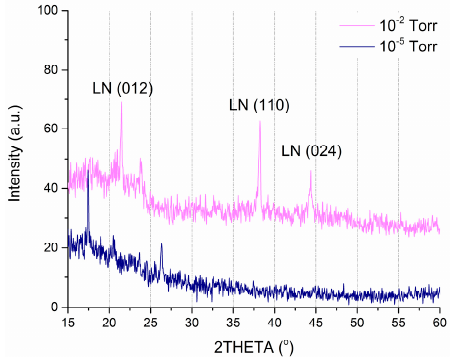
Figure 4. X-ray diffraction (XRD) spectra of LiNbO 3 films, fabricated at an oxygen pressure of 1 × 10 − 2 Torr and 1 × 10 − 5 Torr.